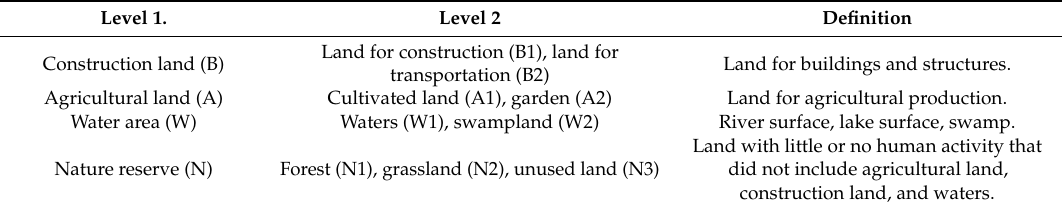
Table 1. Land-use Table 1. Land-use reclassifications.